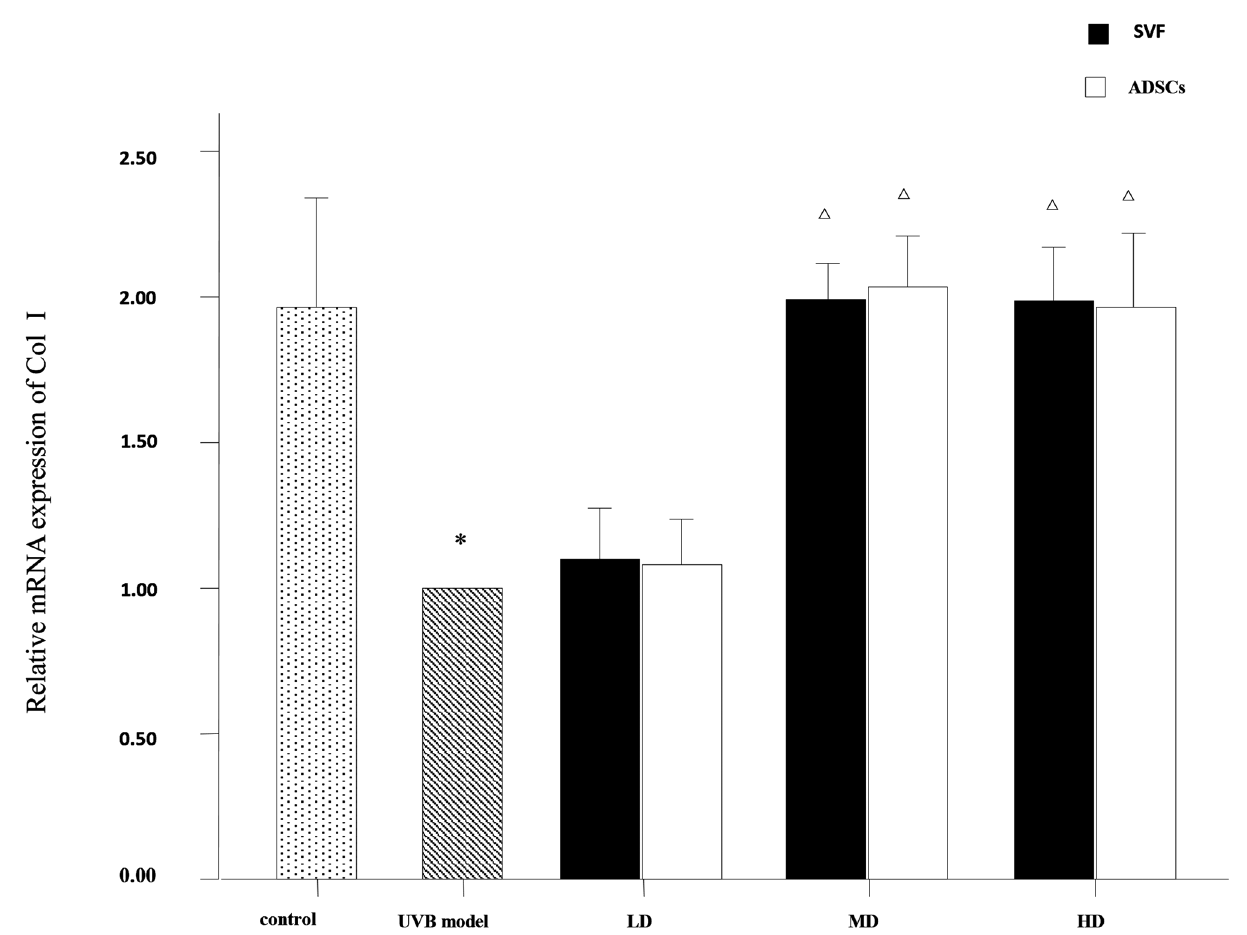
FIGURE 6 | Quantitative polymerase chain reaction (qPCR) showed the relative mRNA expression of collagen I of nude rats exposed to UVB 28 days after SVF and ADSCs treatment. Mean±SD. n =6. * P <0.05 vs control group. △ P <0.05 vs UVB model